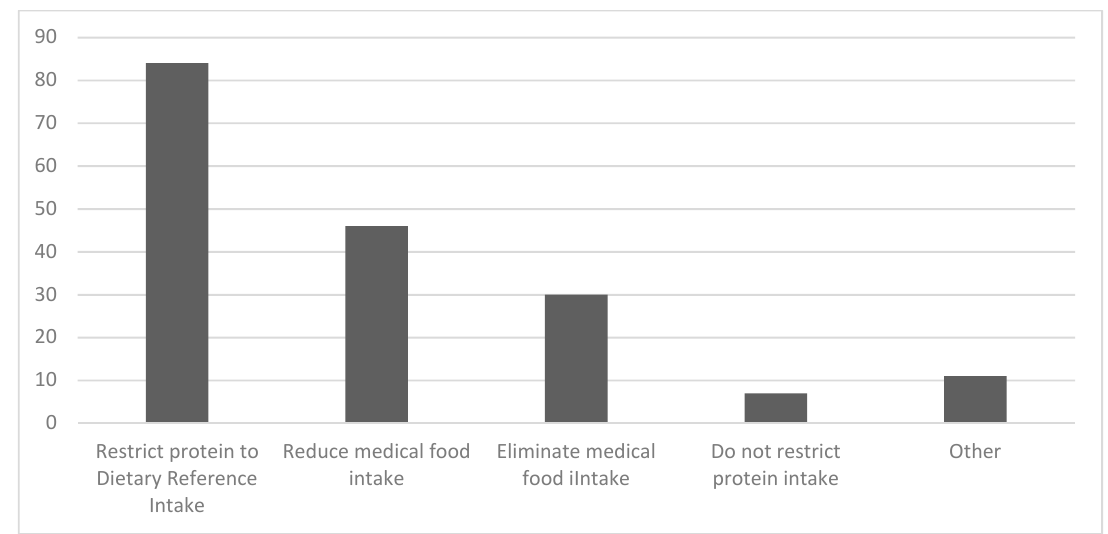
Figure 1. Survey responses to defining diet liberalization in glutaric aciduria type 1 (GA-1) (% of responses in each category).